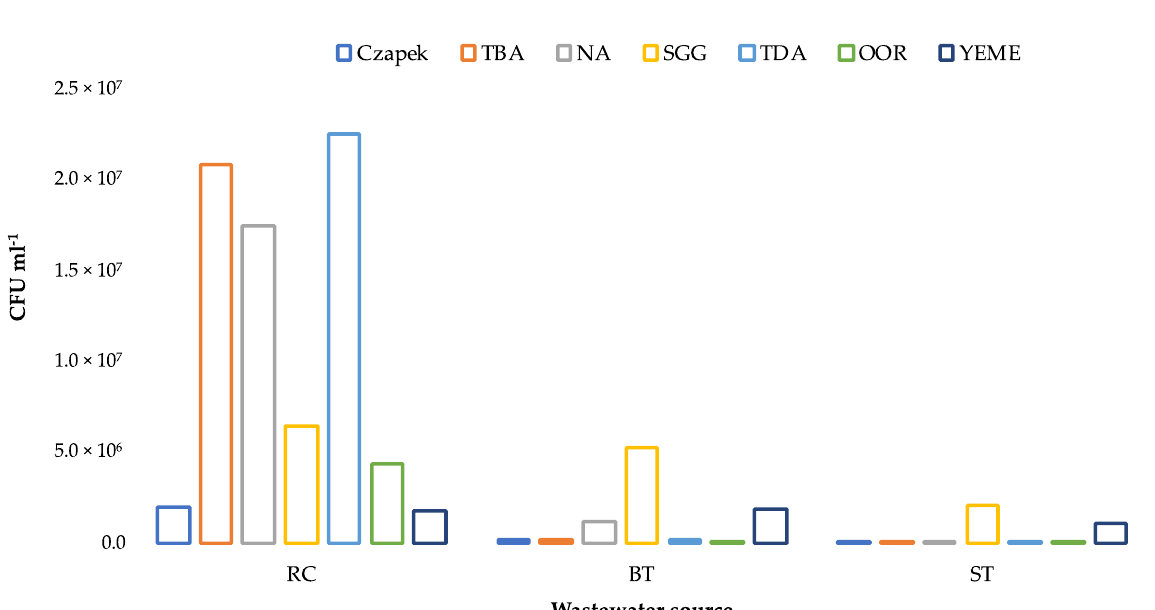
Figure 1. Bacterial counts obtained from selected wastewater samples on different media. TBA = tributyrin agar; NA = nutrient agar; SGG = starch, glycerol, glucose agar; TDA = tween degradation agar; OOR = olive oil Rhodamine agar; YEME = yeast extract malt extract agar; RC = refinery condensate; BT = buffer tank; ST = separator tank.